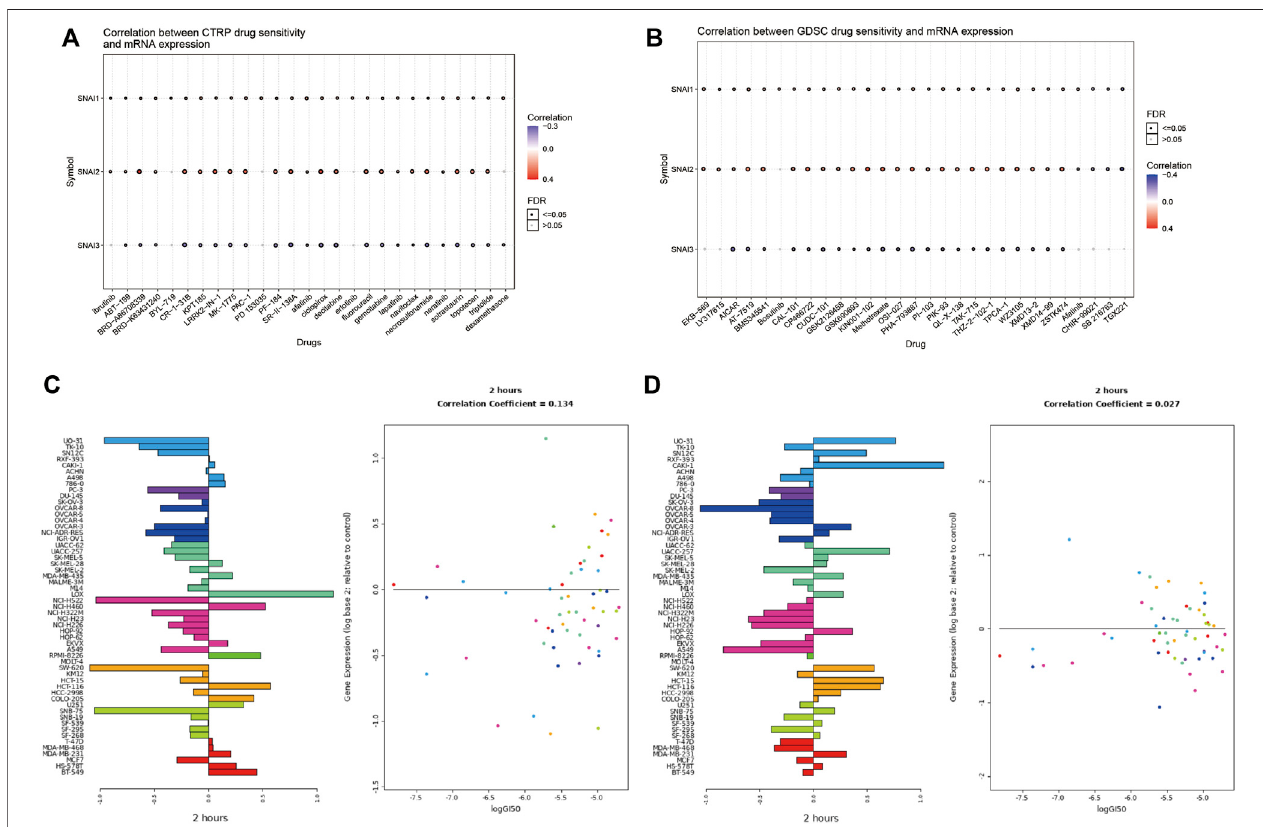
FIGURE 8 | Correlations between drug sensitivity and SNAI expression levels (A) Correlations between drug sensitivity and SNAI mRNA expression based on CTRP data (B) Correlations between drug sensitivity and SNAI mRNA expression based on GDSC data (C) SNAI1 expression levels after lapatinib treatment for 2 h in various cancer cell lines (D) SNAI2 expression levels after lapatinib treatment for 2 h in various cancer cell lines.